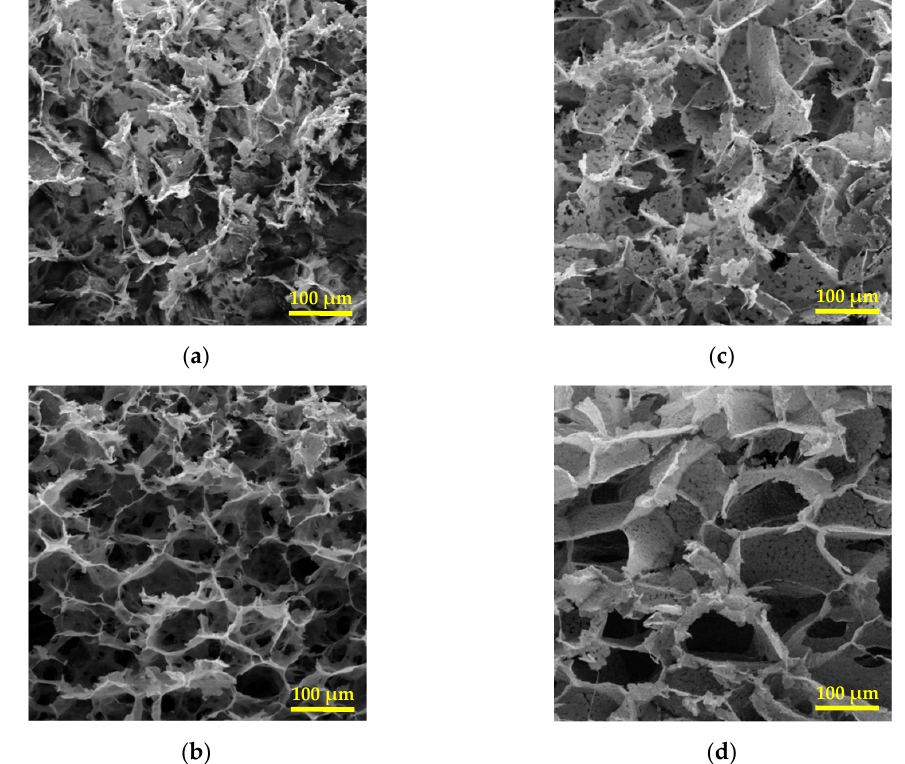
Figure 3. Scanning electron micrographs of cross-sections of PHBV sca ff olds: ( a ) HBV5-R2, ( b ) HBV5-R6, ( c ) HBV12-R2, and ( d ) HBV12-R6.